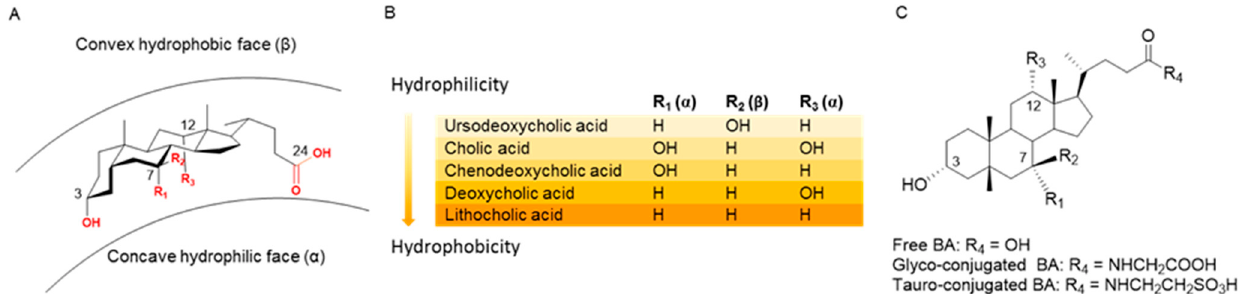
Figure 1. Structure and hydrophobicity of bile acids. ( A ) Perspective structure of BA: the number and the disposition of OH groups affect their hydrophobicity. ( B ) general hydrophobicity scale of BAs. ( C ) chemical structure of free and conjugated BAs.